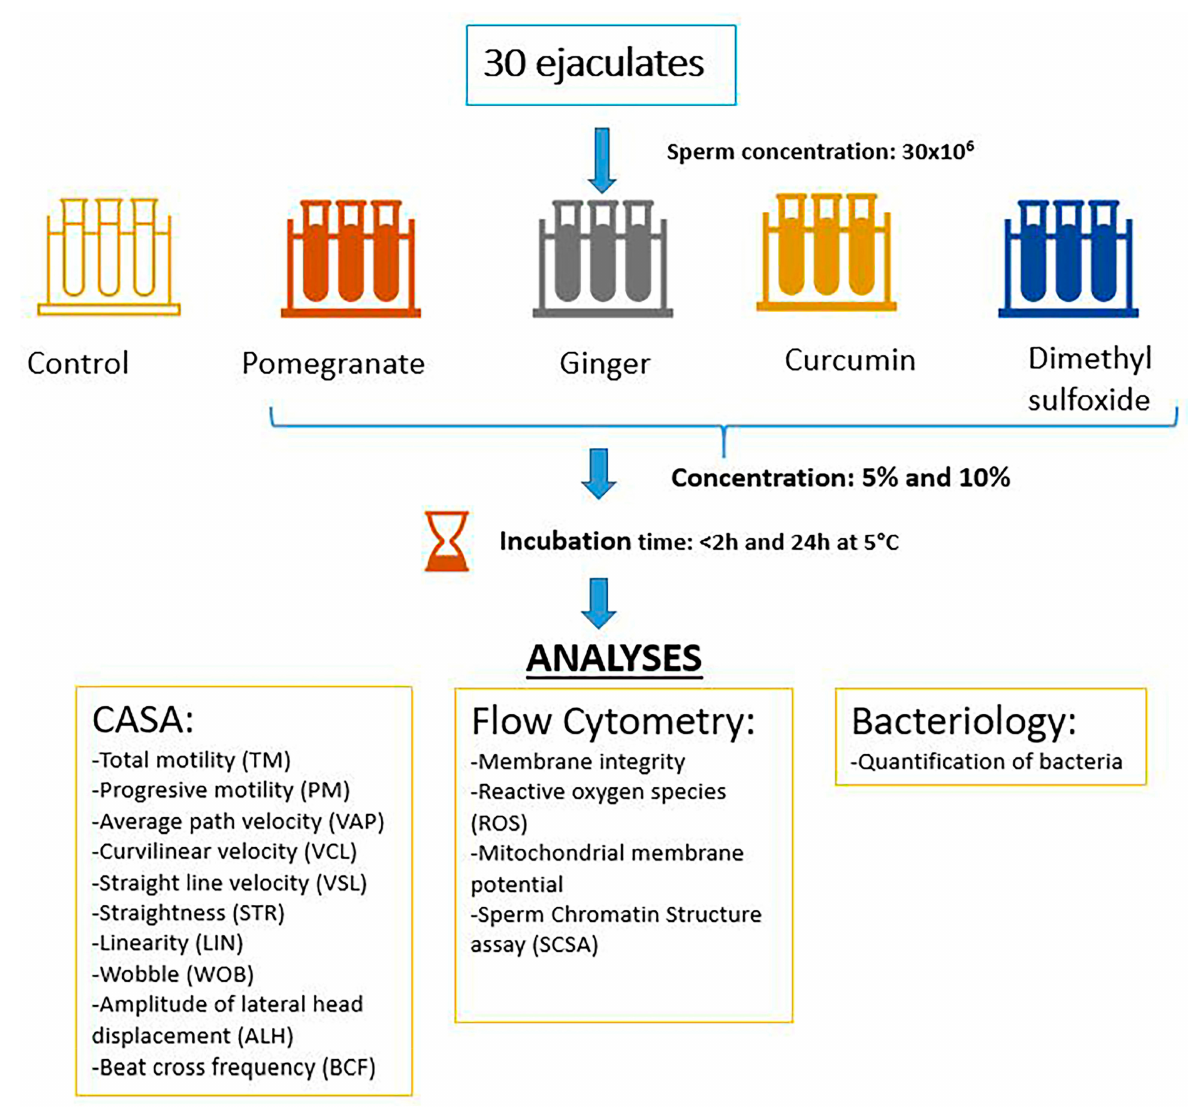
Figure 3. Incubation time and analyses after adding various plant-based substances to bull semen 24 h after collection. In total, semen samples from 10 bulls were used (three ejaculates per bull). Curcumin (Sigma-Aldrich GmbH, Stockholm, Sweden; 5 mg) was dissolved in 500 µ L ethanol (70%) in a plastic test tube, and was then diluted to 15 mL with peptone water (Dilucup) to a concentration of 667 µ g/mL. Thereafter, 5 mL aliquots were centrifuged for 5 min at 4000 × g and 22 ◦ C; the supernatant was